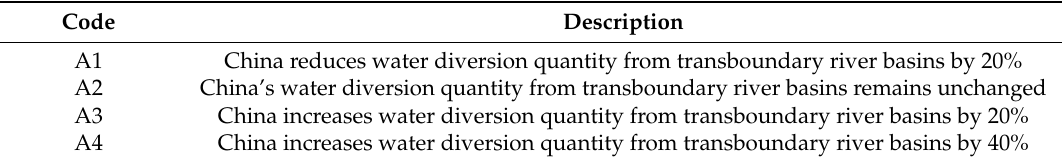
Table 4. The changes of water diversion quantity from transboundary river